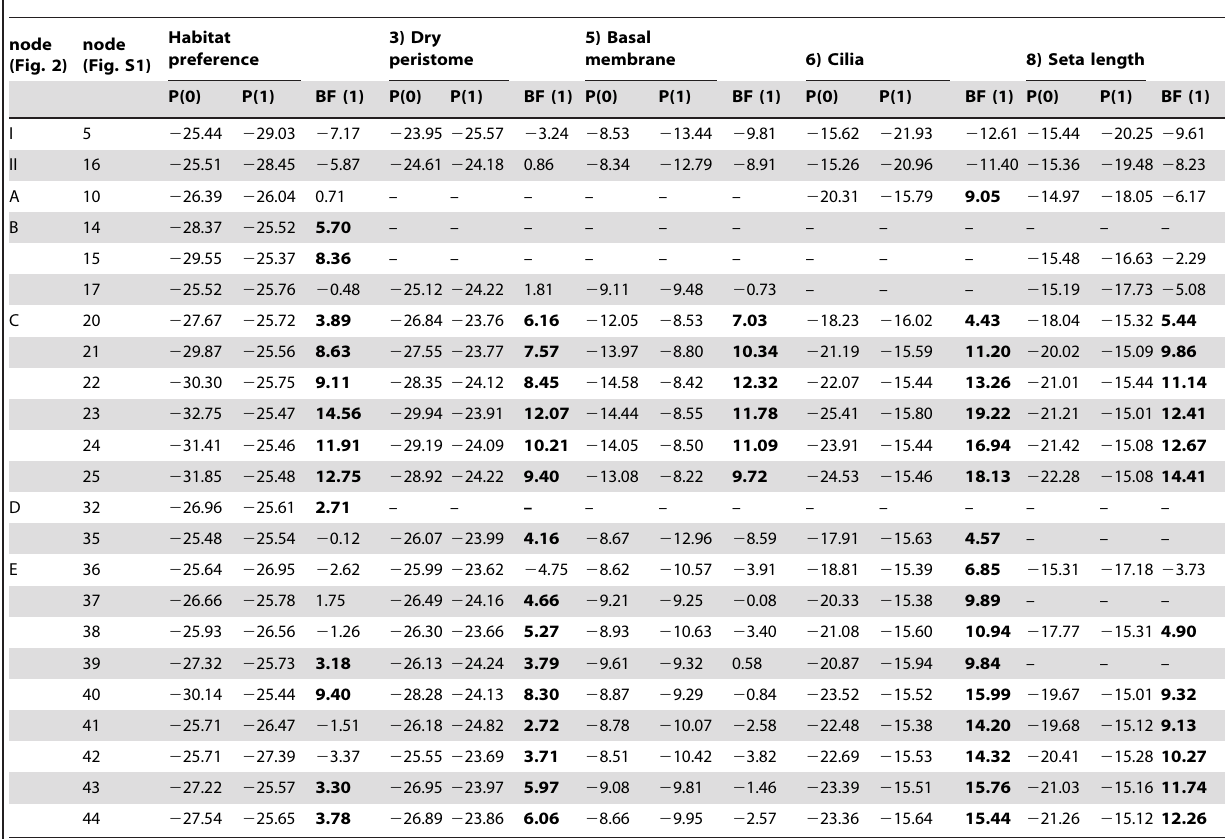
Table 1. Bayes Factor (BF) support for four morphological traits and habitat preference.